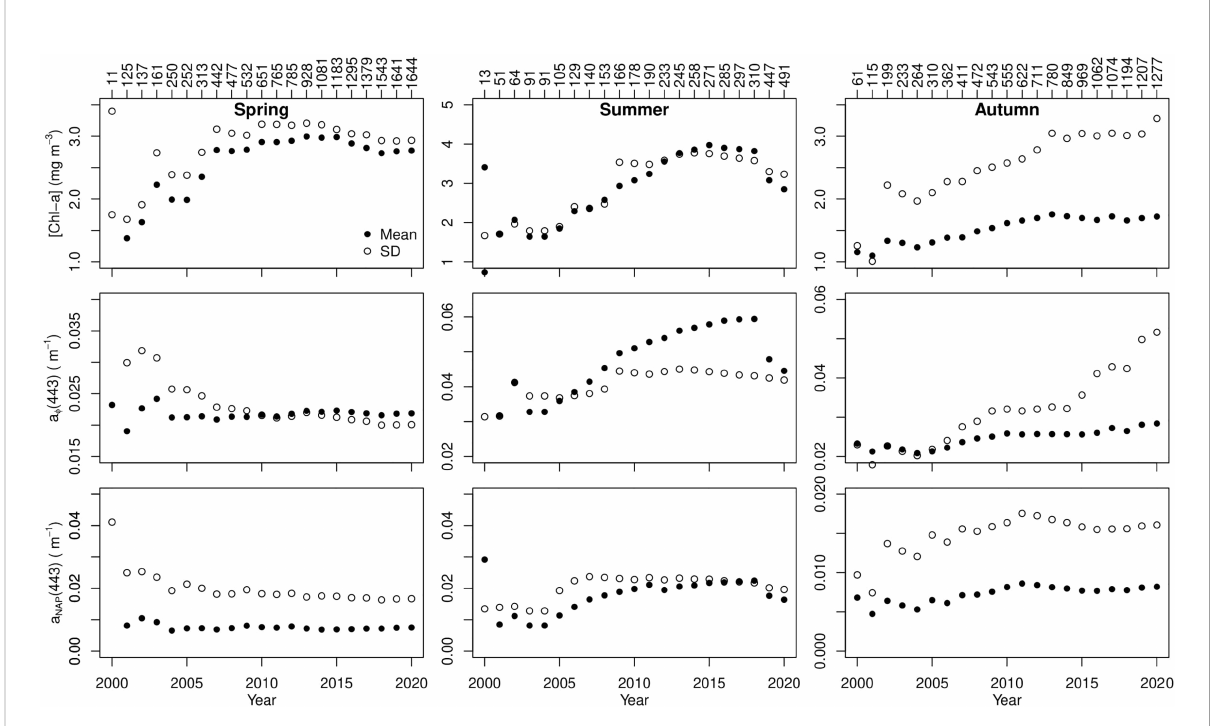
FIGURE 10 Mean (solid black circles) and standard deviation (open black circles) as a function of time for [Chl-a] (top), a f (443) (middle), and a NAP (443) (bottom) (you should use text mode to write NAP instead of math mode; it does not look good) in spring (left column), summer (middle column), and autumn (right column on the Scotian